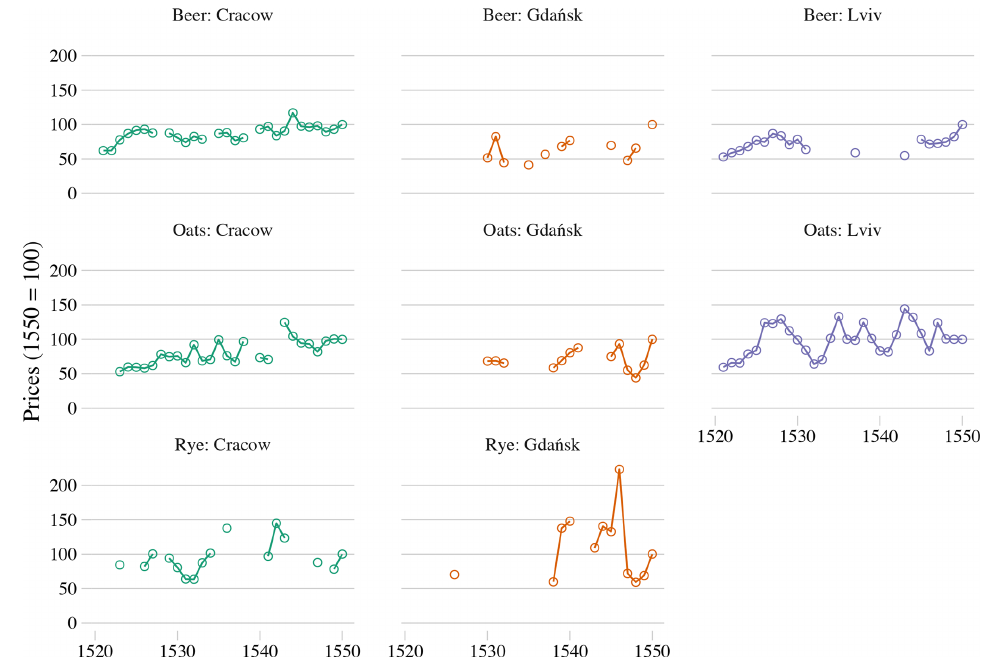
Figure 12. Prices in Kraków, Gda´nsk and Lviv. Source: Pelc (1935, 1937), Hoszowski